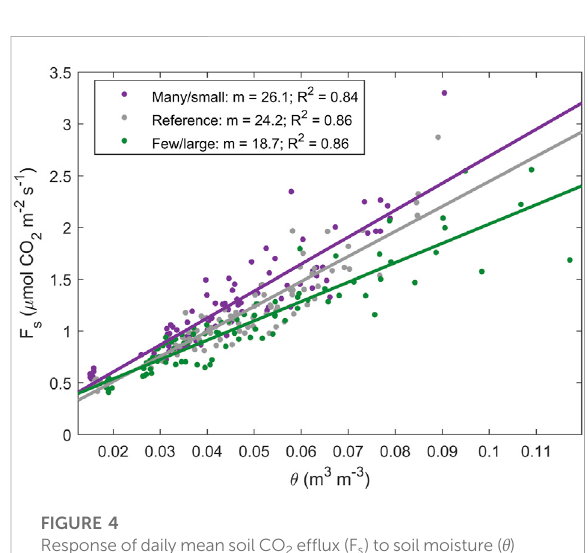
FIGURE 4 Response ofdaily meansoil CO 2 ef fl ux(F s )tosoil moisture ( θ ) colored by rainfall repackaging treatment. Note m is the slope of the regression line for each